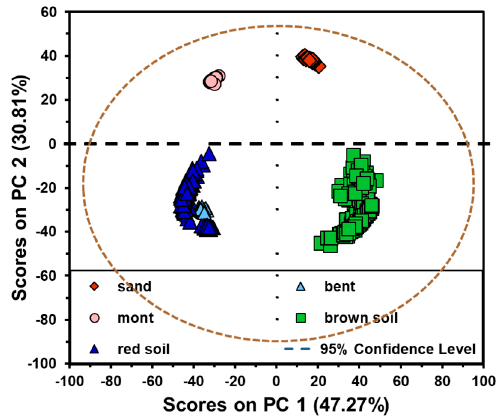
Figure 2. Scores plot of PC 2 vs. PC 1 (principal components) for sea sand (sand), montmorillonite (mont), bentonite (bent), brown soil, and red soil. The 95% confidence level is also shown. Reflectance spectra of samples containing sea sand, red soil, and brown soil mixed with 8% and 10% w / w petroleum, are shown in Figure 3. Changes in spectral features for soils and sea sand samples, with and without the pollutant, are visible.